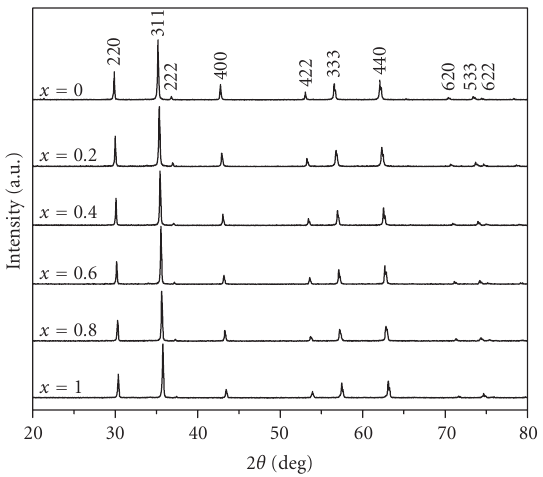
Figure 1: X-ray di ff raction pattern of MnAl x Fe 2 . 0 − x O 4 system.